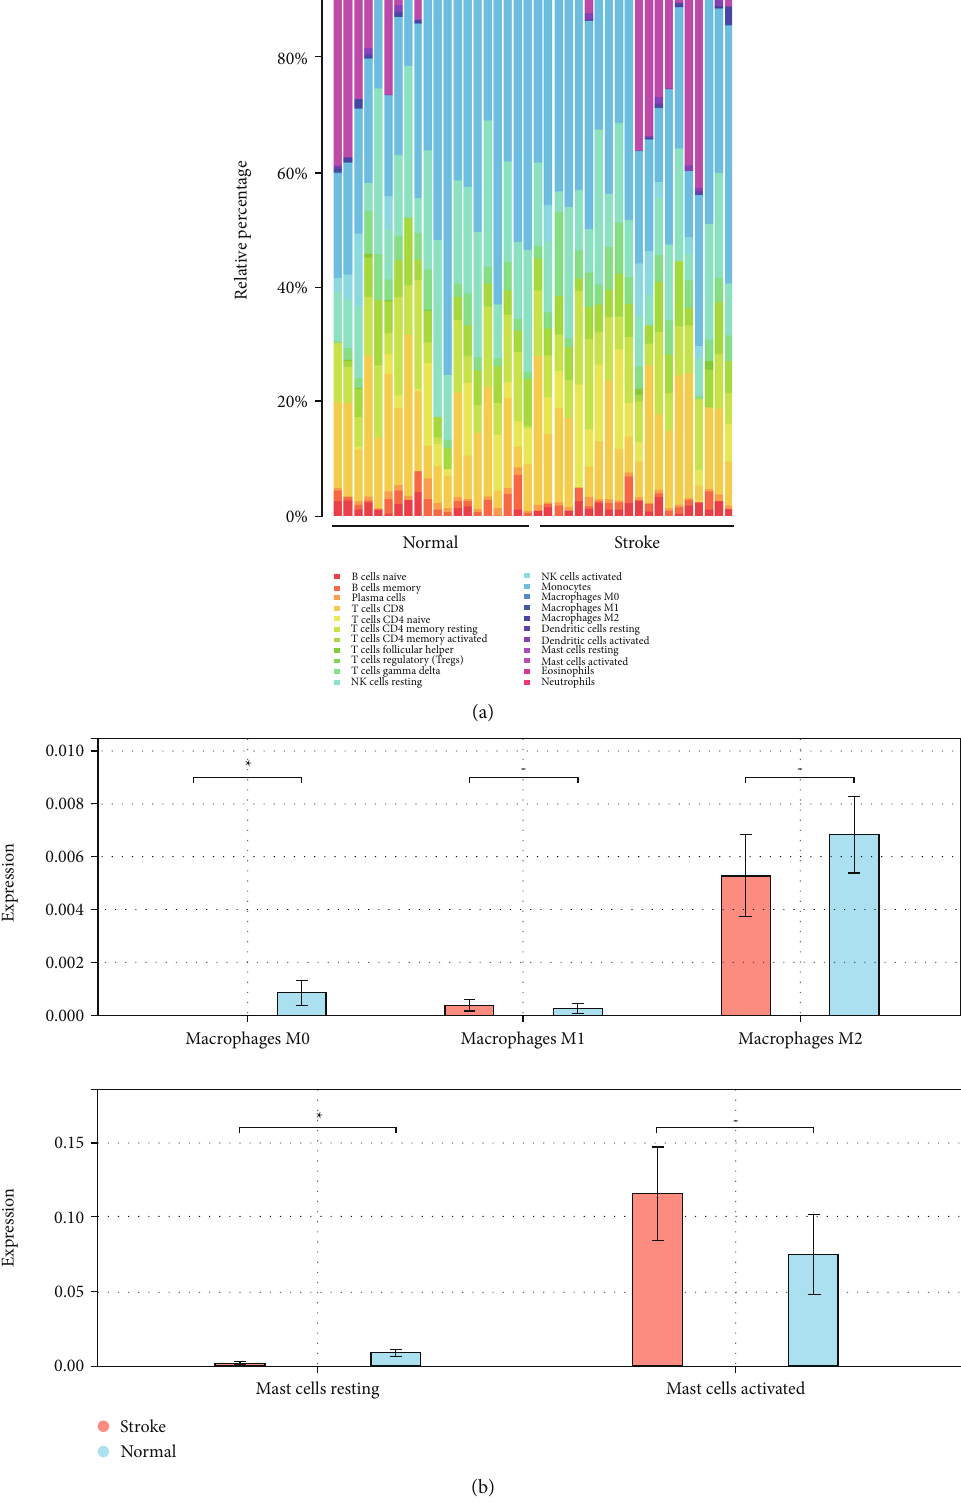
Figure 6: Immune cell patterns in the peripheral bloods of IS samples. (a) The composition of immune cells in the peripheral bloods of IS patients. (b) Comparison of the indicated immune cell subtypes between stroke and normal control group. ∗ P < 0 : 05